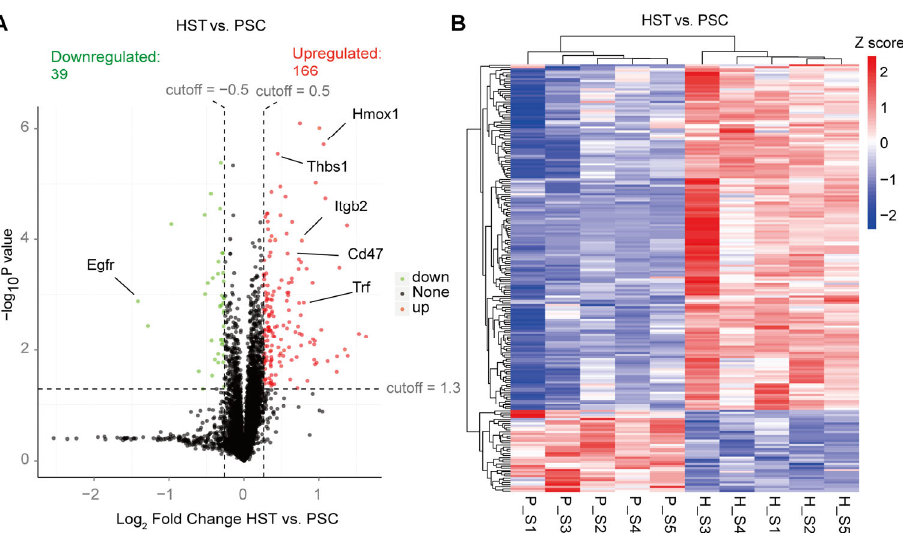
Figure 1. TMT-based proteomic analysis on mice spleen subjected either hypoxia (HST) or normaxia (PSC) conditions. ( A ) Volcano analysis representing the significantly differentially expressed proteins (DEPs). ( B ) Heatmap representing the visualized relative Z scores for each DEP induced by hypoxia treatments. The Z scores were indicated in different colors of cells. The detailed information of protein, e.g., Egfr, was referred to Table S2.